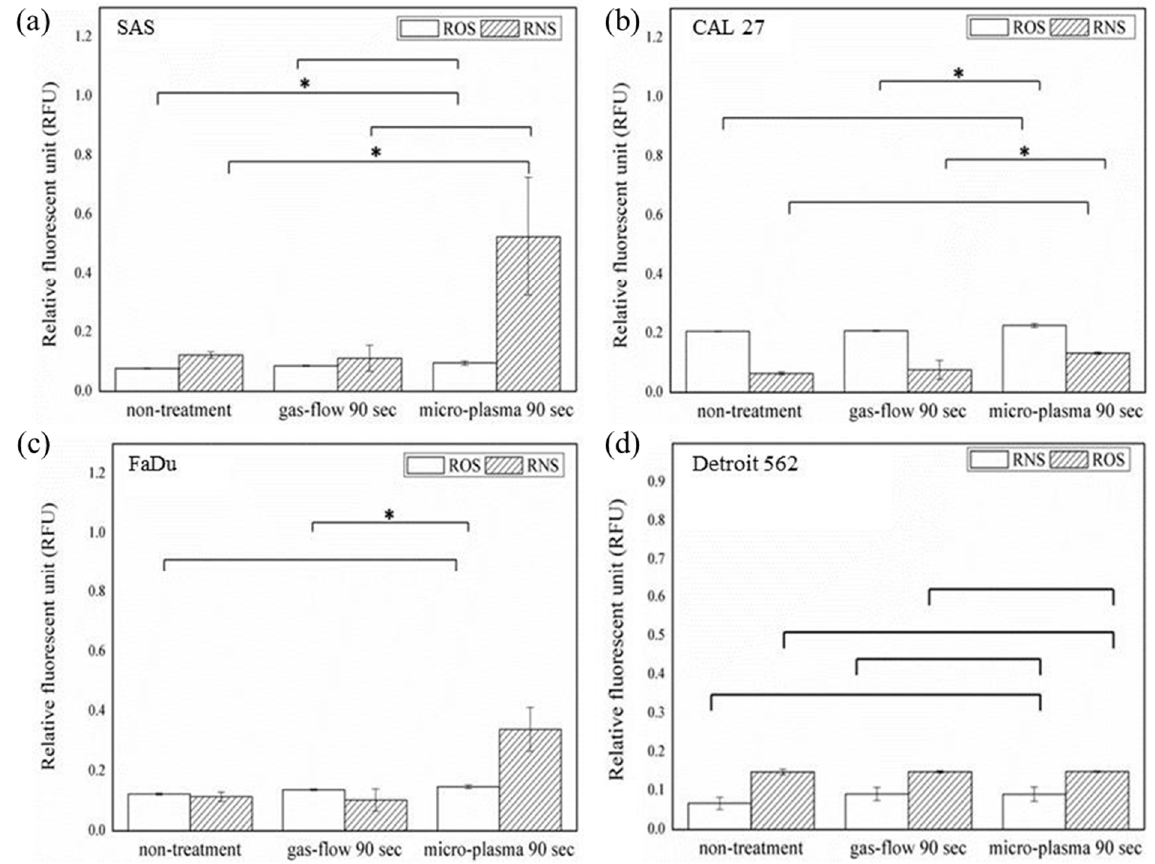
Figure 4. Intracellular ROS/RNS levels of ( a ) SAS, ( b ) CAL 27, ( c ) FaDu, and ( d ) Detroit 562 after N 2 /He plasma exposures of 90 s and then cultured for 48 h. The medium without cells and the medium with cells and gas flow for a similar duration were taken as the references. The values of p < 0.05 (*) and p < 0.01 (**) were considered statistically significant.